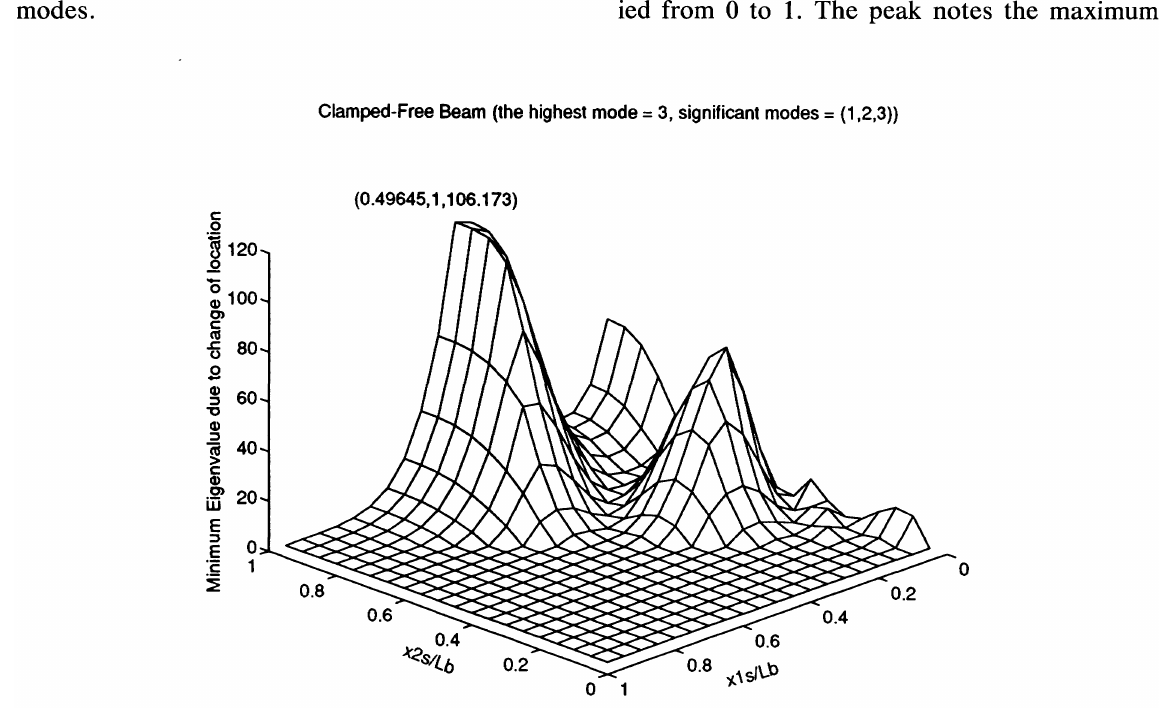
FIGURE 11 Minimum eigenvalue of W~ in clamped-free